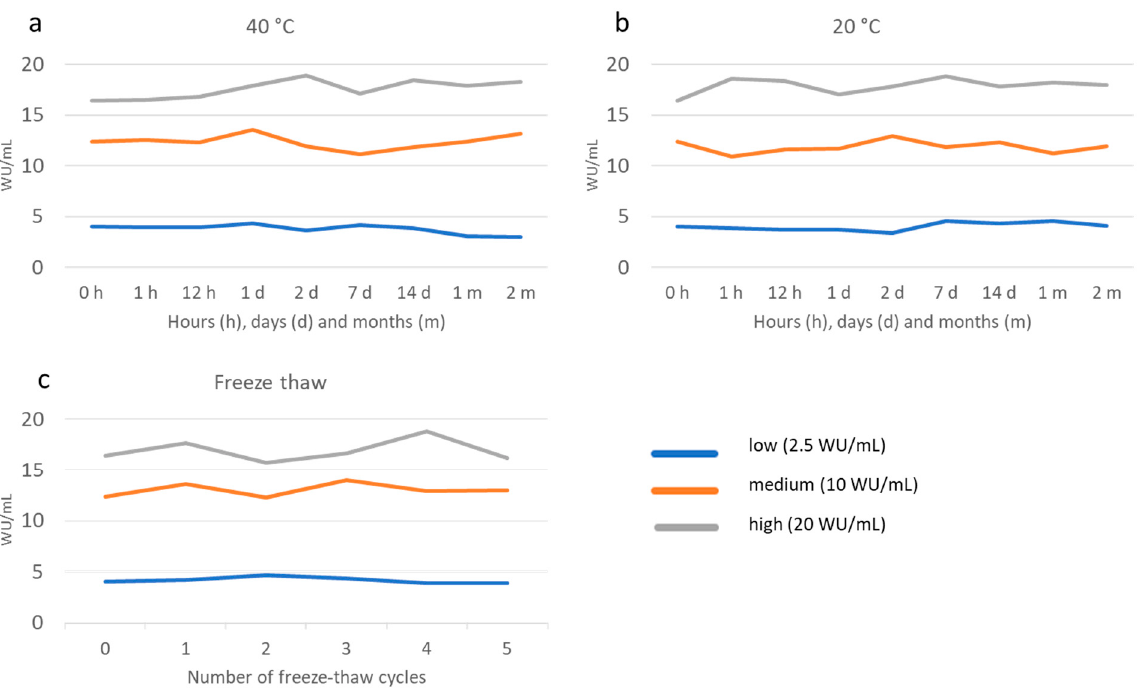
Figure 3. Stability of DBS stored at 40 °C ( a ) and 20 °C ( b ) for up to 60 days and a various number of freeze-thaw cycles ( c ) as measured by HEV IgG in international units (WU/mL) at various time points.